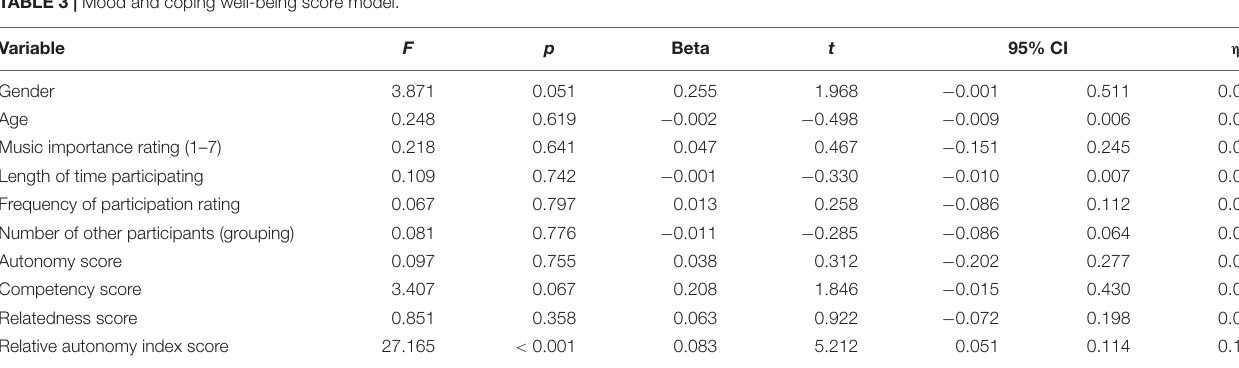
TABLE 3 | Mood and coping well-being score